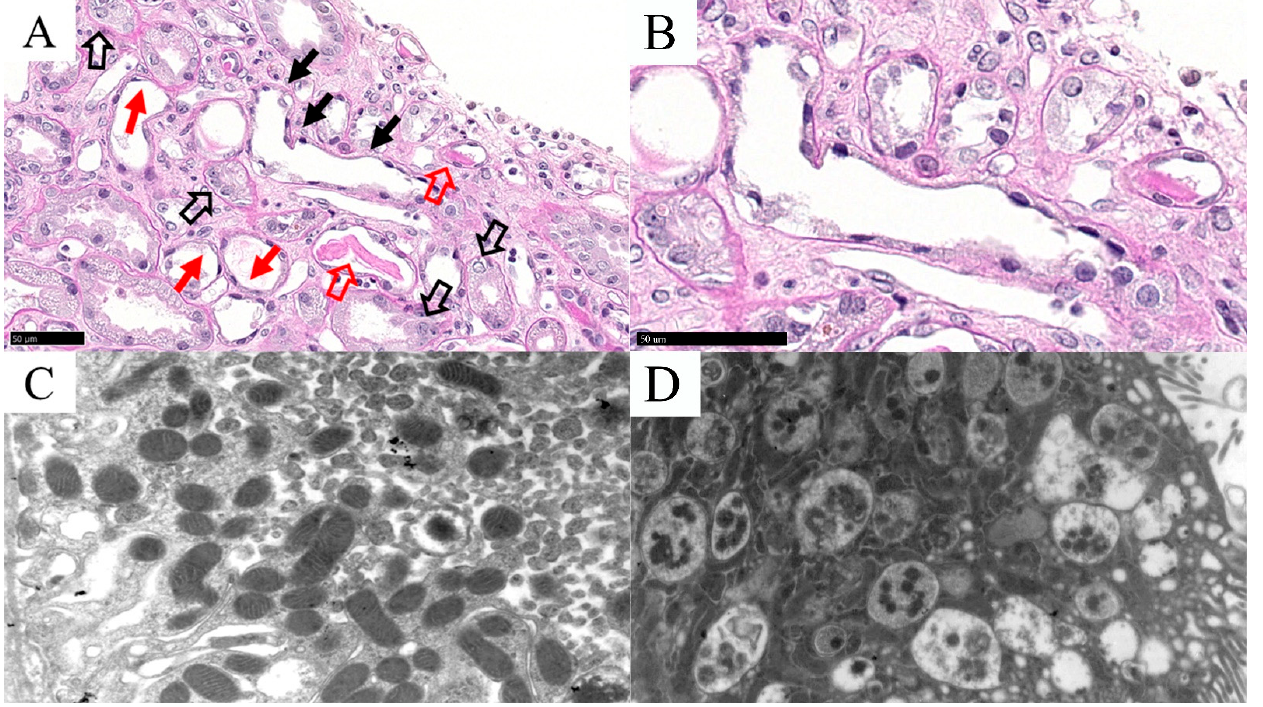
Figure 1. Histomorphological and ultrastructural features of Case 1. PAS stain ( A ) highlighted epithelial cell death (i.e., loss of or pale staining nuclei and eosinophilic cytoplasm; full black arrow), nuclei regenerative atypia (empty black arrow), and reduced or absent brush borders (full red arrow); eosinophilic casts in tubular lumens were also observed (empty red arrow) containing nuclear and cytoplasmic debris originated from necrotic tubular epithelial cells. Details of an injured tubules of the same area at high-power magnification ( B ). EM analysis confirmed the acute tubular injury showing mitochondrial condensation ( C ), and increased phagolysosomes ( D ).